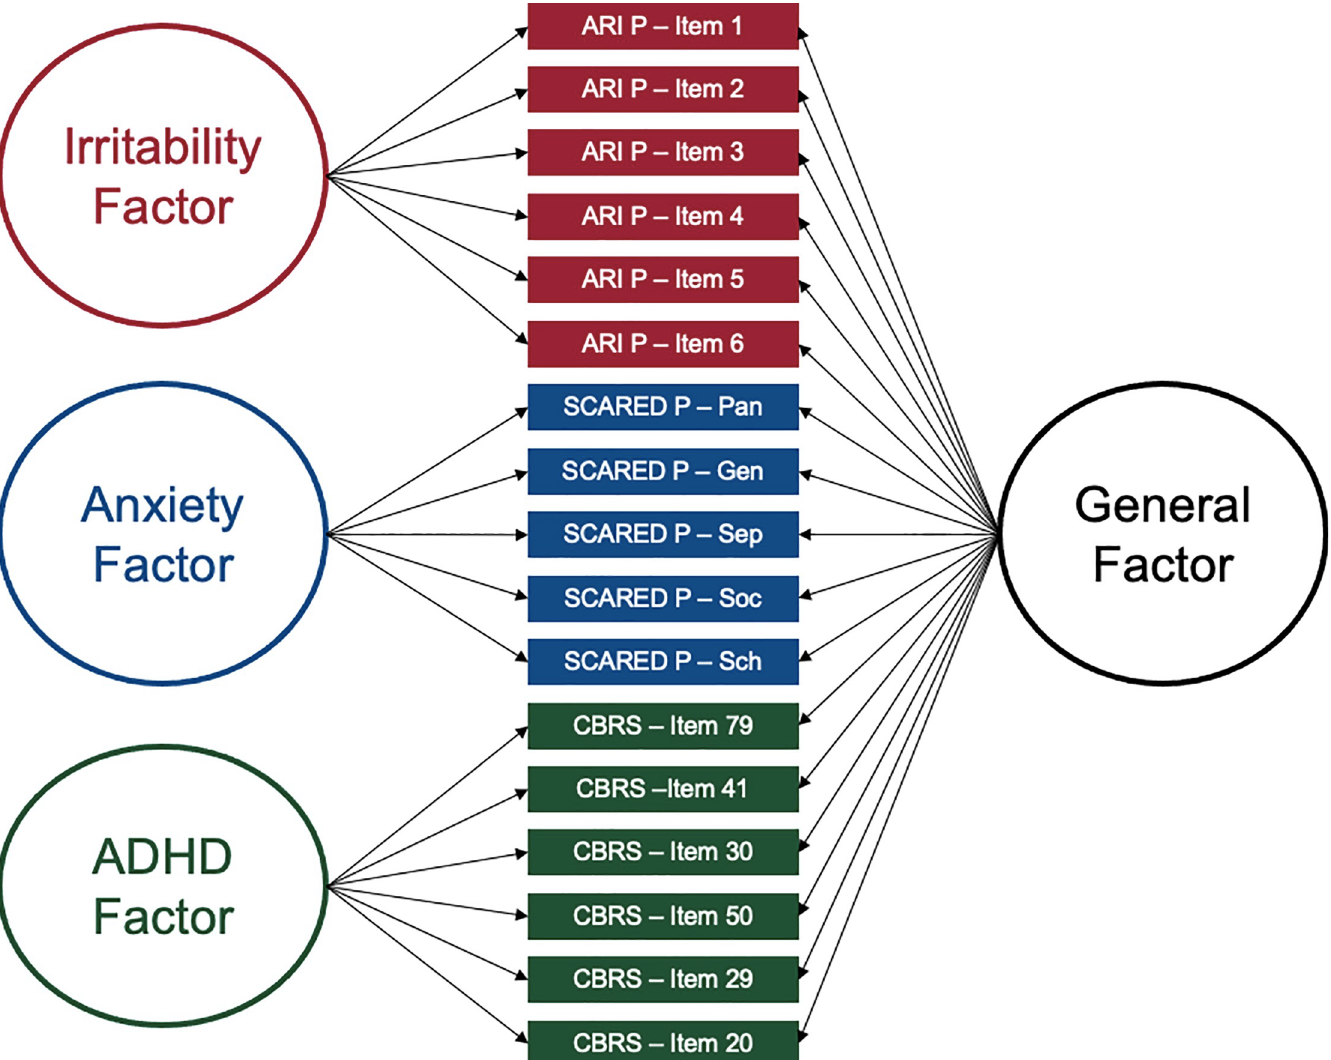
Fig 3. Bifactor model for clinical symptoms. Note: ARI P = Parent-Report Affective Reactivity Index, SCARED P = Parent-Report Screen for Anxiety Related Emotional Disorders, CBRS = Conners Comprehensive Behavior Ratings.